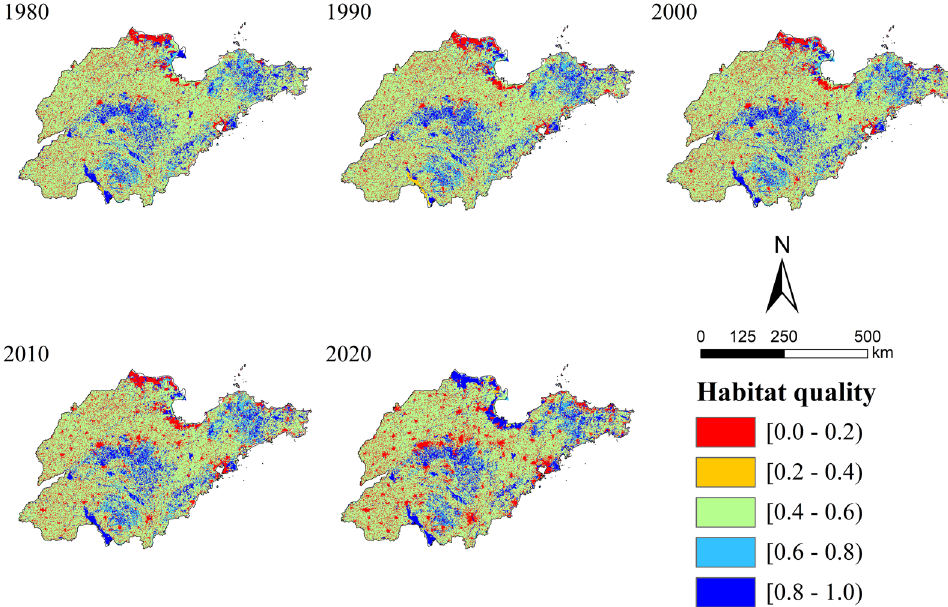
Figure 6. Distribution map of habitat quality in Shandong Province from 1980 to 2020.